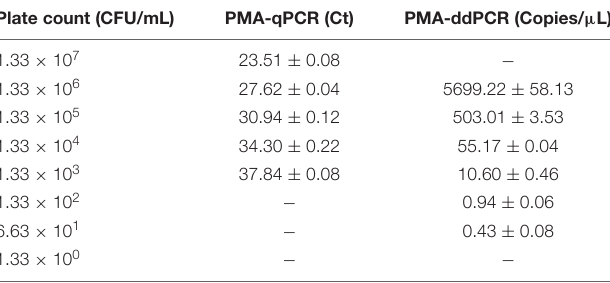
TABLE 3 | Comparison of detection results of PMA-qPCR and PMA-ddPCR in pure culture solutions. Plate count